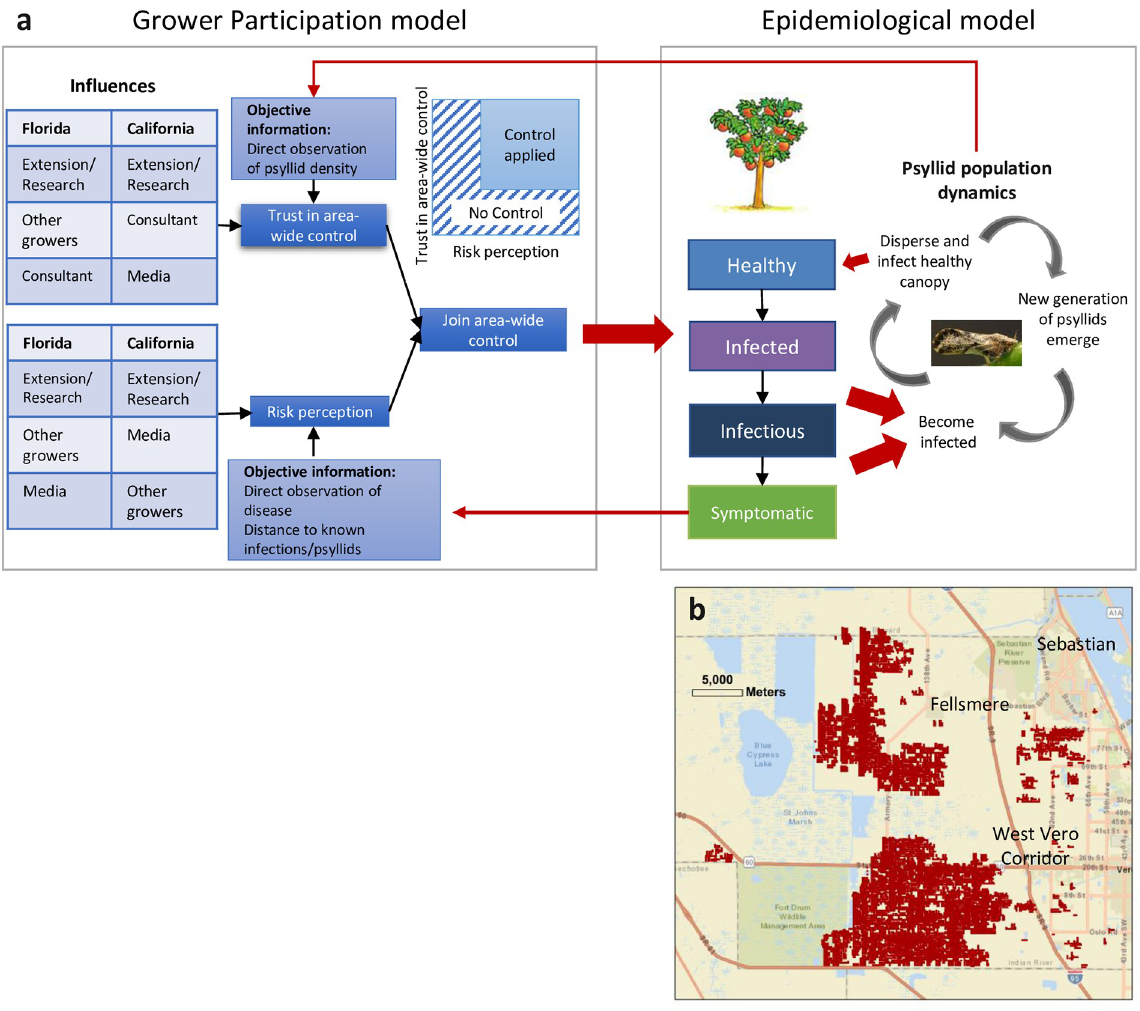
Fig 1. A model of HLB in the landscape. (a) A schematic showing how the grower participation model is linked to the epidemiological model. Growers join an area-wide control program if their risk perception and trust in area-wide control are high. This impacts the psyllid population and so the dynamics of the disease in the landscape. Observations of infection increase risk perception and can erode the trust in area-wide control. Red arrows indicate where models interact. (b) A simulated landscape representing a typical Citrus Health Management Area in Florida. The area where commercial citrus is grown is indicated by red